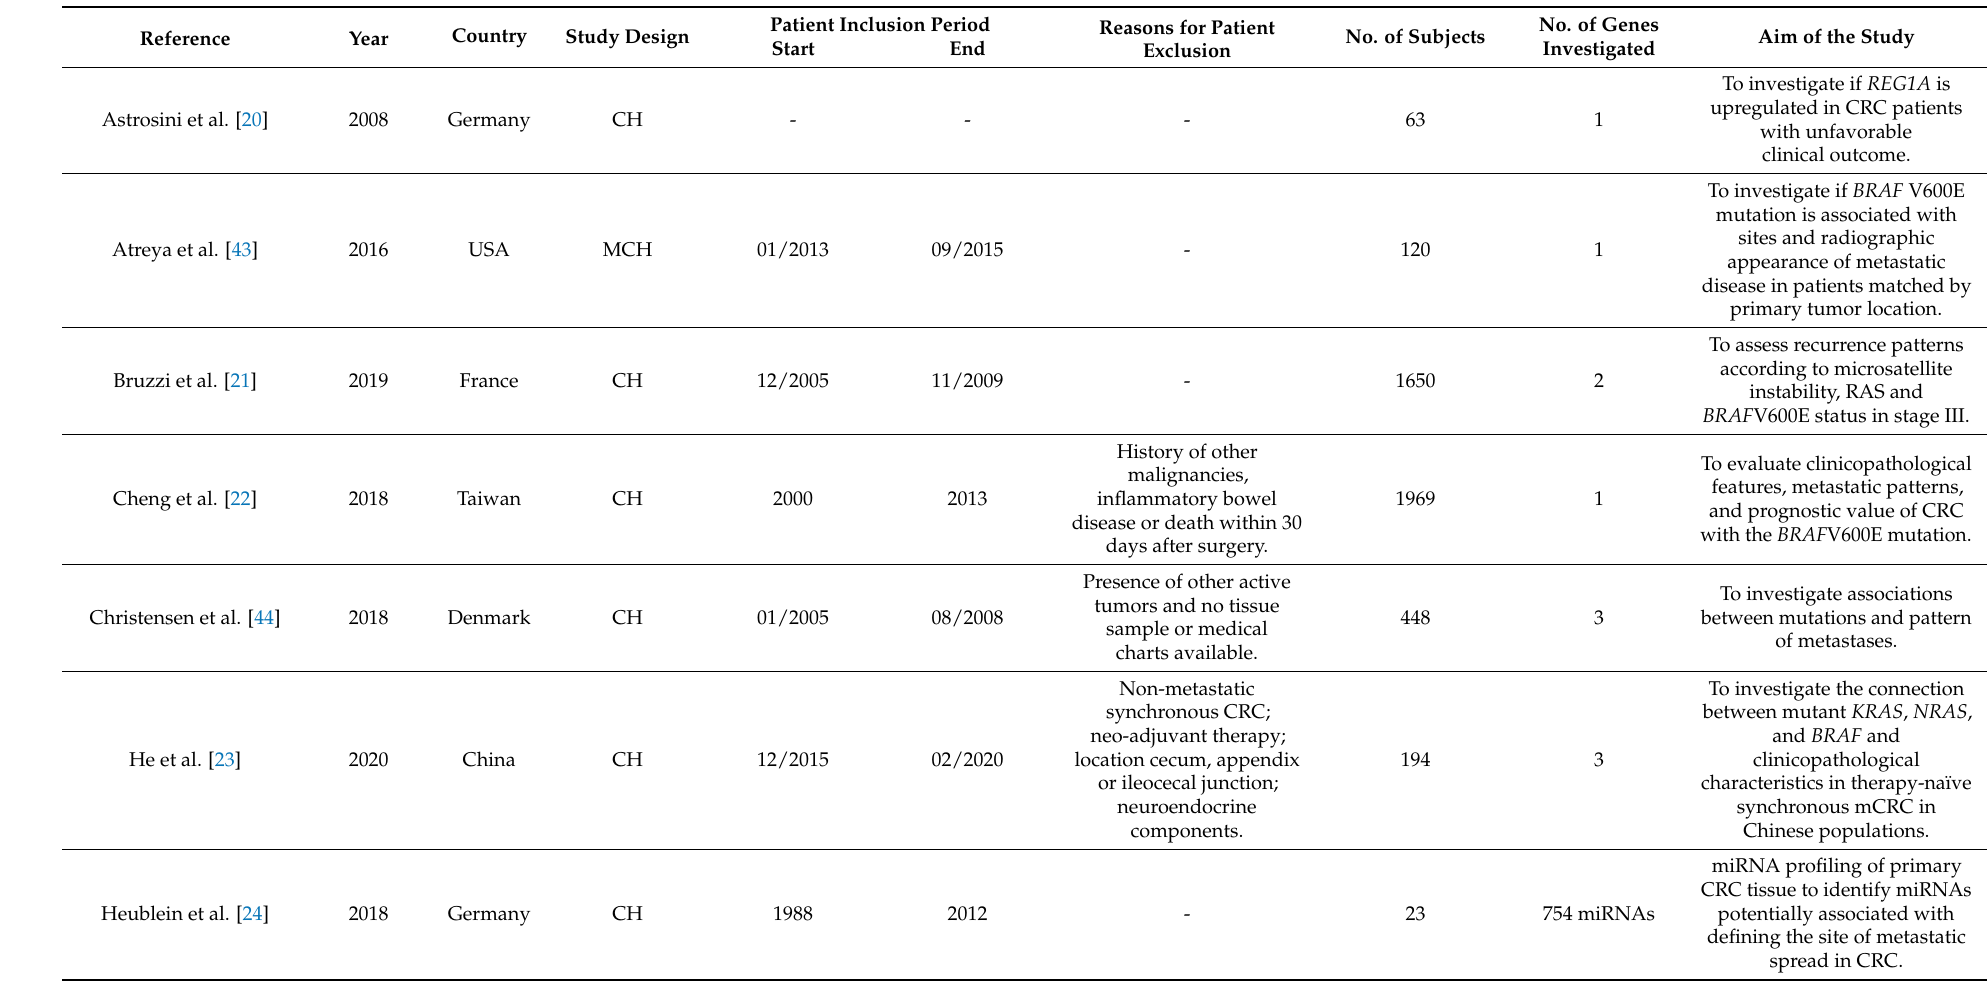
Table 1. Characteristics of included